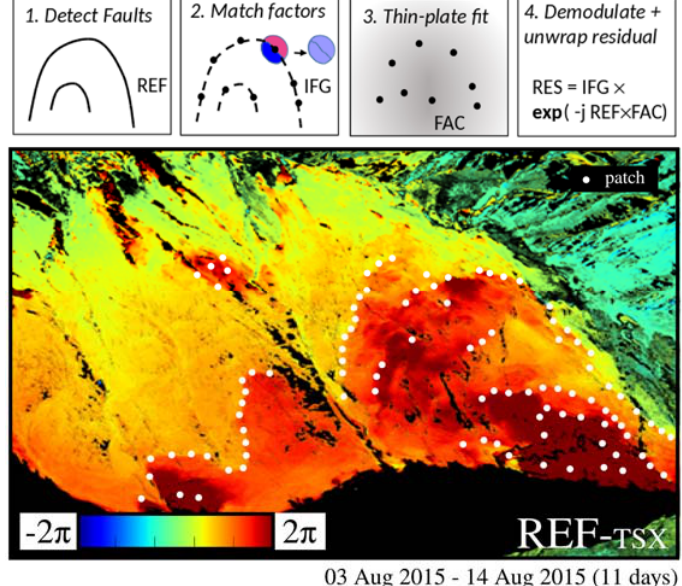
Figure 1. Top: the four steps of the warp demodulation method; IFG: to ‐ be ‐ demodulated wrapped interferogram; REF: high ‐ resolution unwrapped reference interferogram; FAC: interpolated factor map; and RES: wrapped residual. Bottom: real data example of reference interferogram (TerraSAR ‐ X Staring Spotlight, 0.6 m ground resolution), Fels Glacier Slide, Alaska.